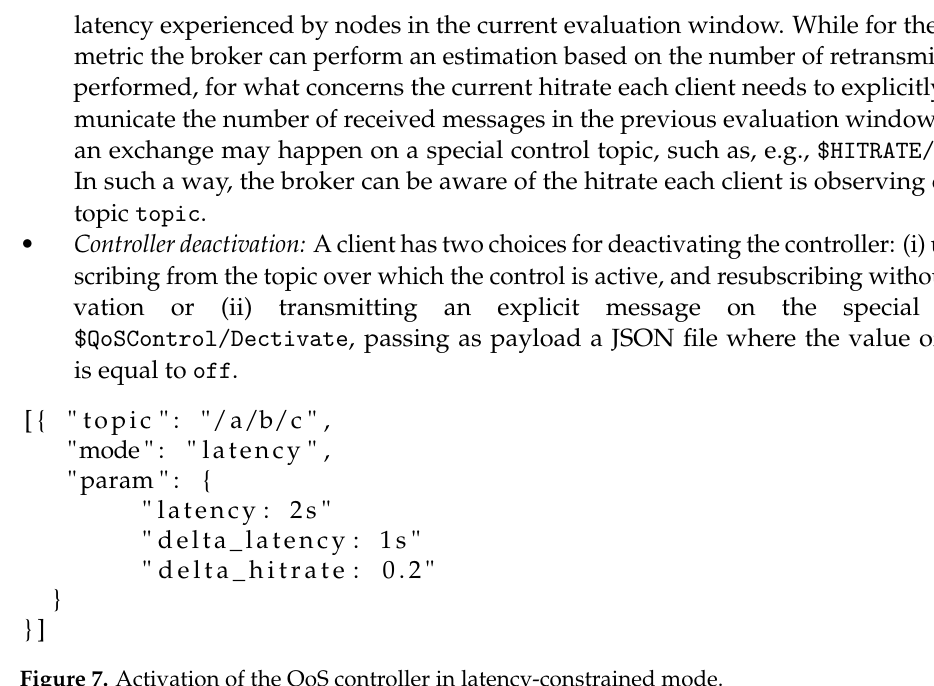
Figure 7. Activation of the QoS controller in latency-constrained mode.